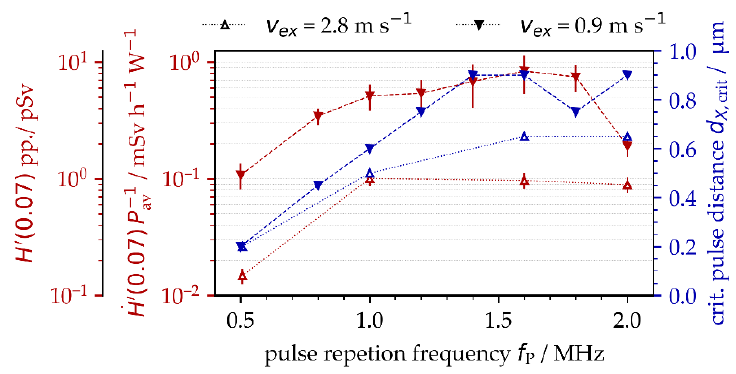
Figure 6. X-ray emission doses per pulse and X-ray emission dose rates related to the applied average laser power as a function of PRF detected at different suction flow speeds. The critical intra-line pulse distances for maximum X-ray emissions are presented.